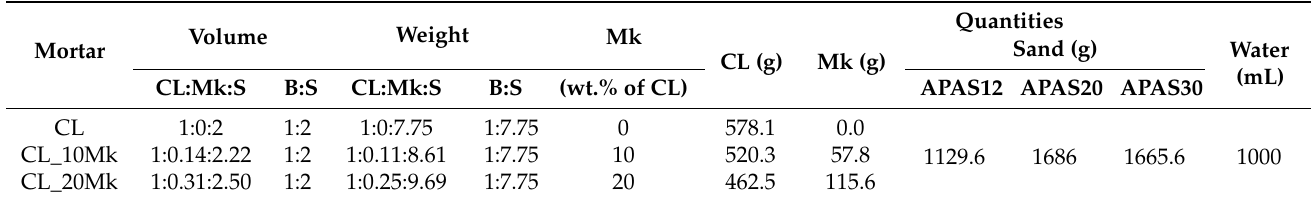
Table 3. Composition of